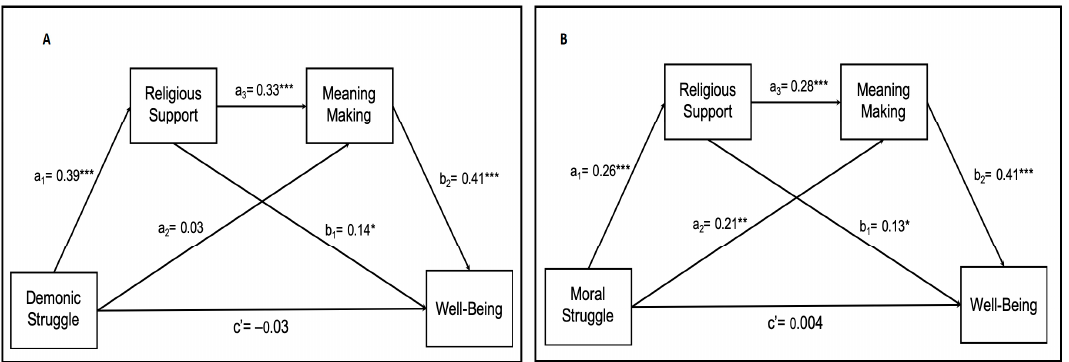
Figure 1. Standardized regression coefficients for the relationships between demonic ( A ) and moral ( B ) struggle and well-being as mediated by religious support and meaning making. Significance level: *** p < 0.001; ** p < 0.01; * p < 0.05.